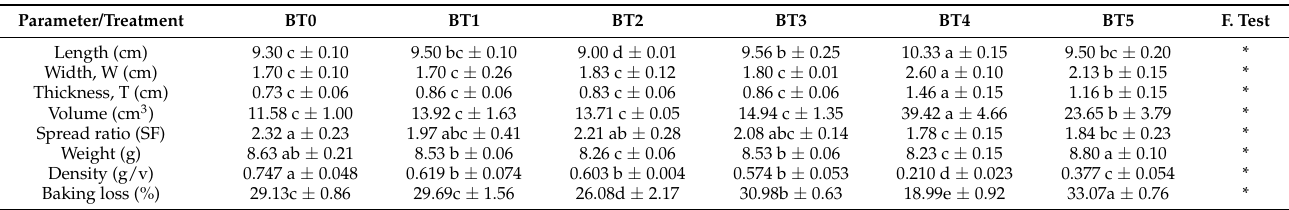
Table 4. Some essential mineral contents for biscuit